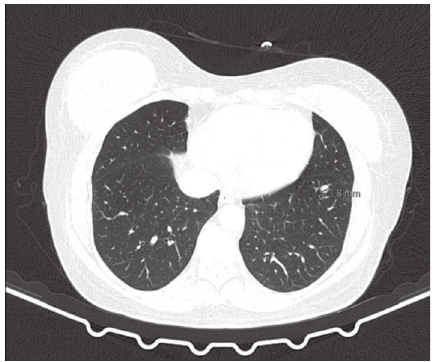
Figure 1: Transverse section of a thorax CT scan presenting an 8 mm pulmonary